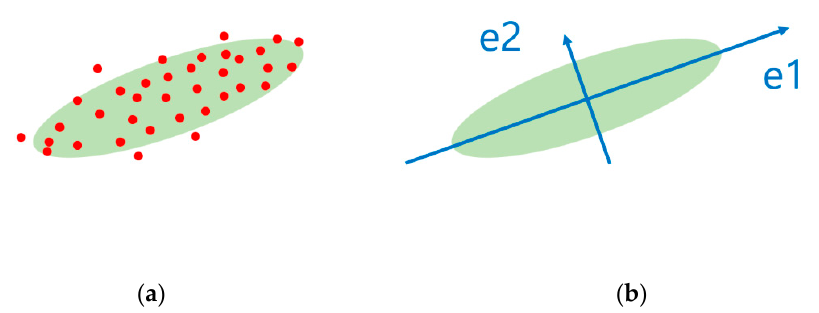
Figure 1. ( a ) Original distributed data and ( b ) distributed data with PCA technique